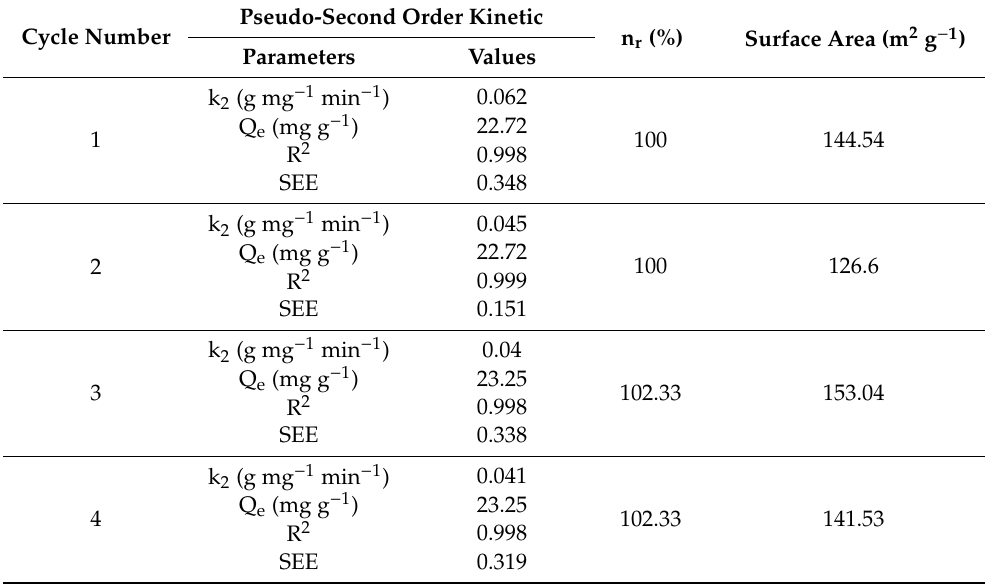
Figure 5. Uptakes of [bpy] Cl onto S-Fe during four adsorption–regeneration cycles. Full lines are the pseudo-second order kinetic fit. Table 6. Pseudo-second order kinetic fit of [bpy] Cl adsorption onto S-Fe, regeneration efficiency and surface area during four adsorption–regeneration cycles.